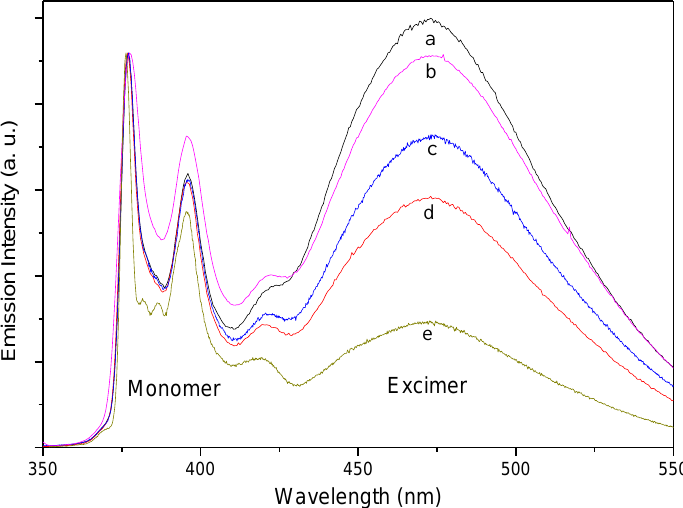
Figure 5. Fluorescence spectra of 10 μg/L PDMAA-12.7 copolymers ( a ) in water, ( b ) in water with equivalent γ-CD, ( c ) in water with equivalent β-CD, ( d ) in water with equivalent α-CD and ( e ) in ethanol. Excitation wavelength was 344 nm and the emission spectra were normalized at 377 nm.